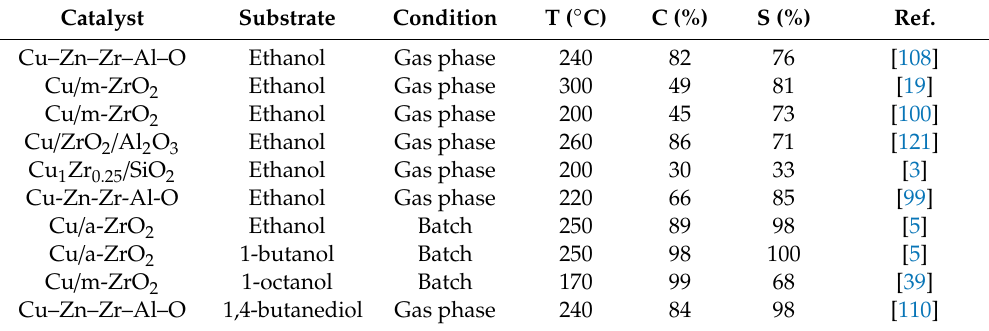
Table 2. Comparison between the di ff erent Cu-, Zr-based catalysts in DHC reaction.